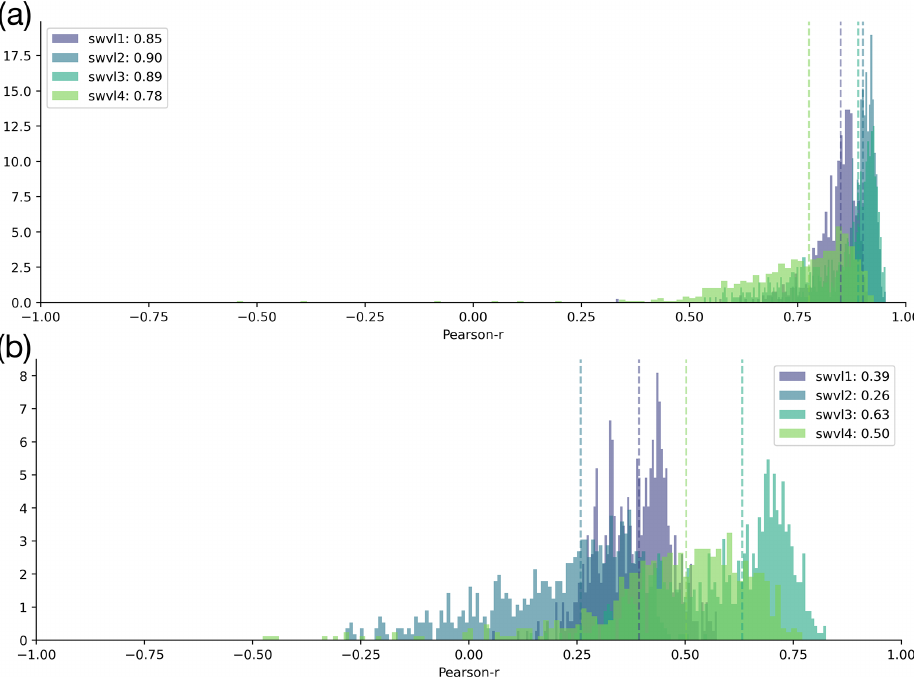
Figure A4. Shifting in time. (a) Histograms of the original experiments with unshuffled data, repeated from Fig. 2. (b) Histograms of catchment correlation scores after having trained the probes on data shifted in